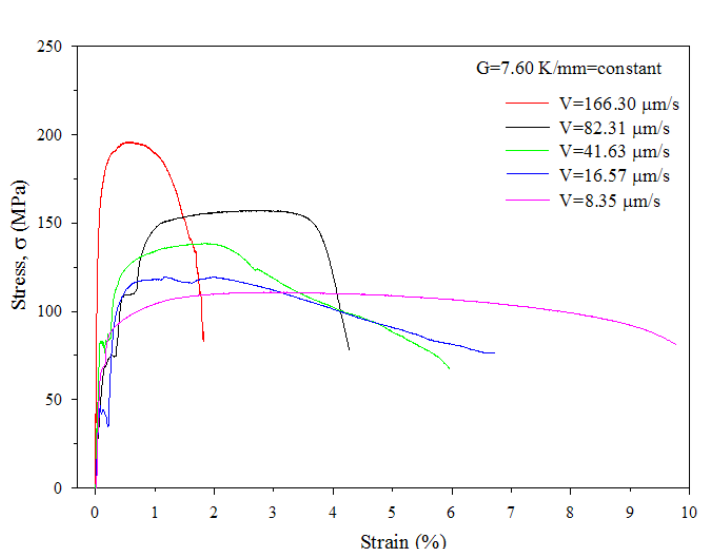
Fig 5. Variation of stress vs.